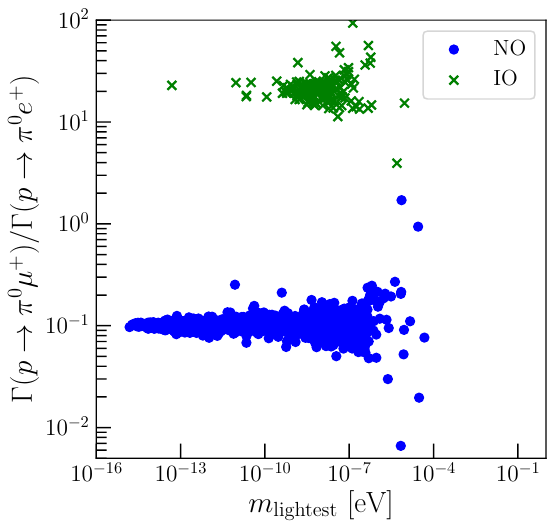
(cid:25) 0 (cid:22) + ) = (cid:0)( p (cid:25) 0 e + ) in the (cid:13)ipped SU(5) GUT model ! !